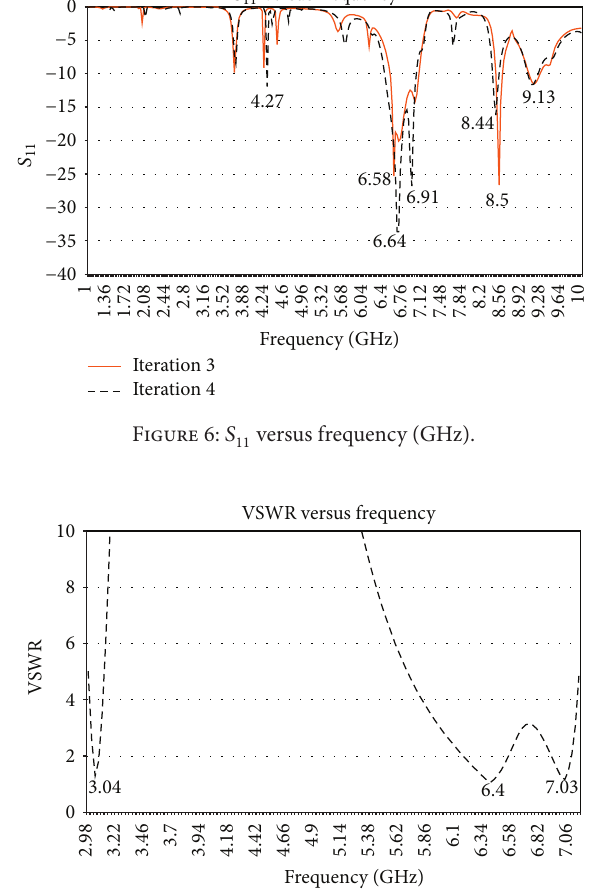
Figure 7: VSWR for iteration